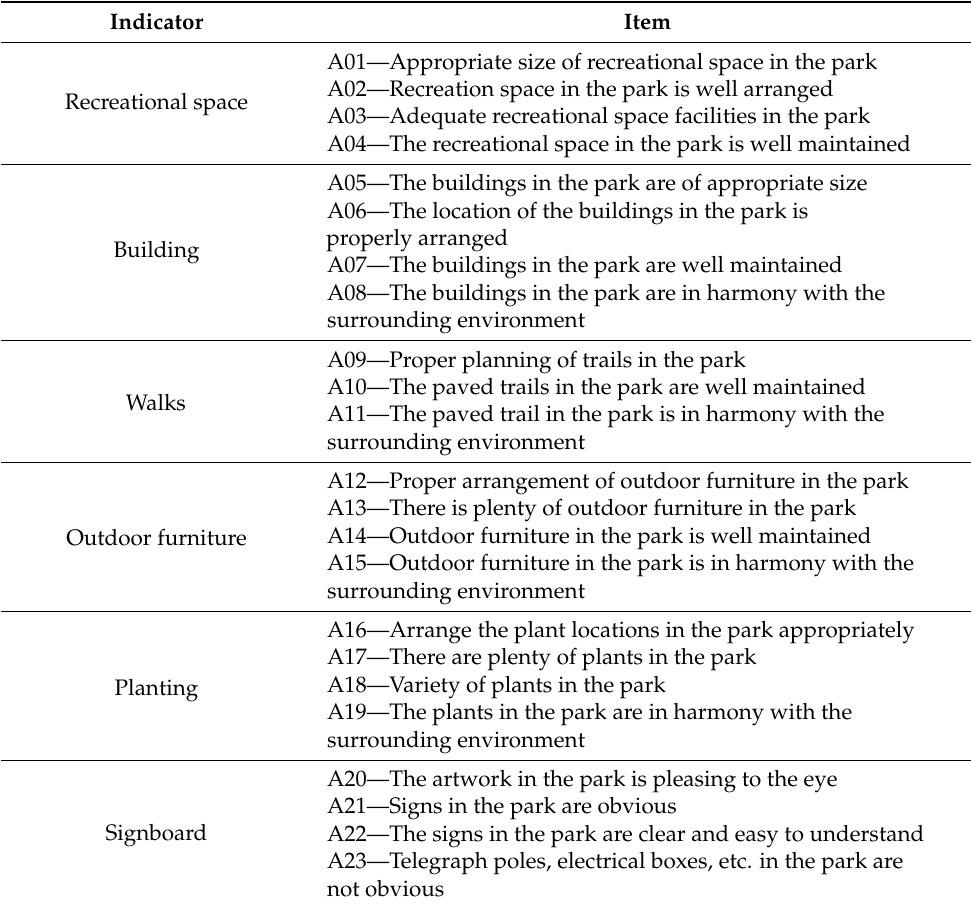
Table A1. Measurement items for environmental